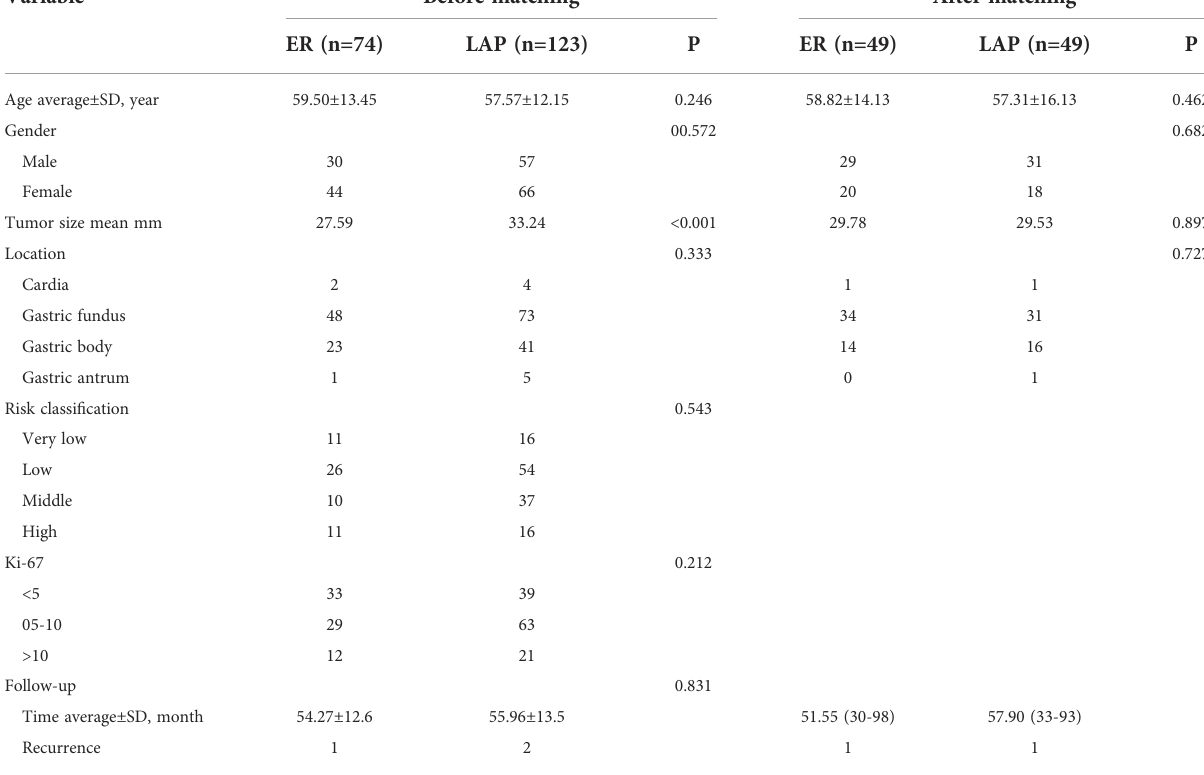
TABLE 1 Baseline characteristics of patients with gastric GISTs (2 – 5 cm) undergoing ER or LAP in the cohort.